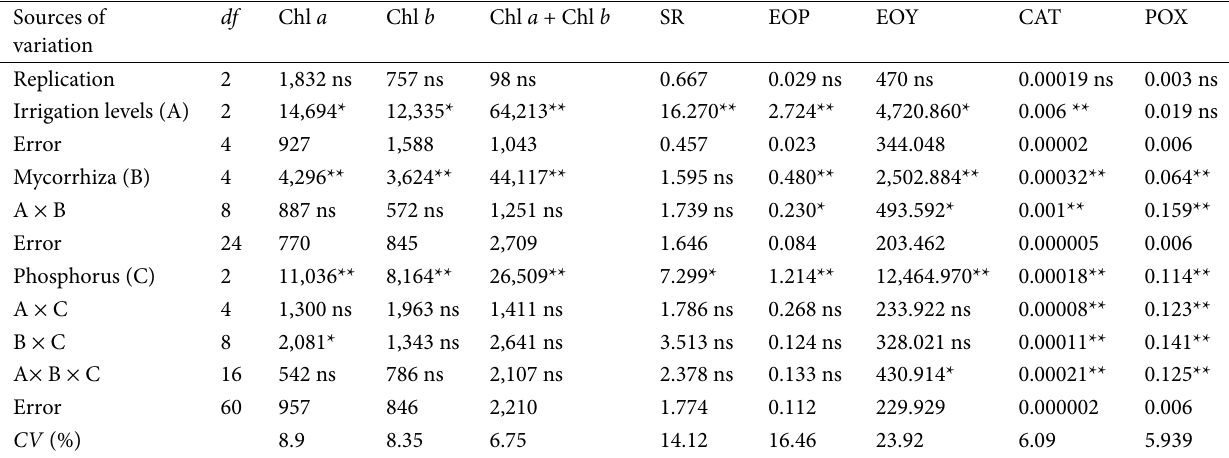
Table 2 Analysis of variance of chlorophyll a (Chl a ), chlorophyll b (Chl b ), stomatal resistance (SR), essential oil percentage (EOP) and essential oil yield (EOY), catalase (CAT), and peroxidase (POX).